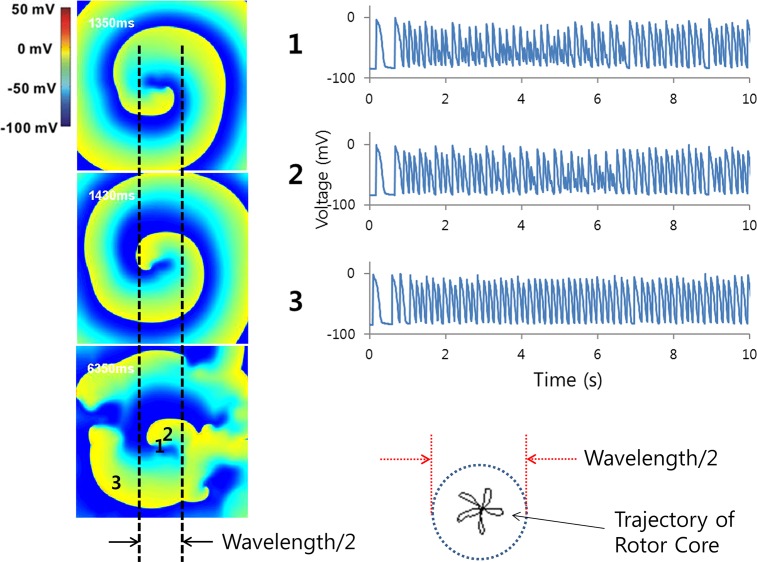
Spatial definition of mother rotor.The trajectory of a mother rotor tip remains within a circle of a diameter that is half the wavelength. Action potentials at three different locations (the center and periphery of the mother rotor tip trajectory and the periphery of the mother rotor) are also shown.